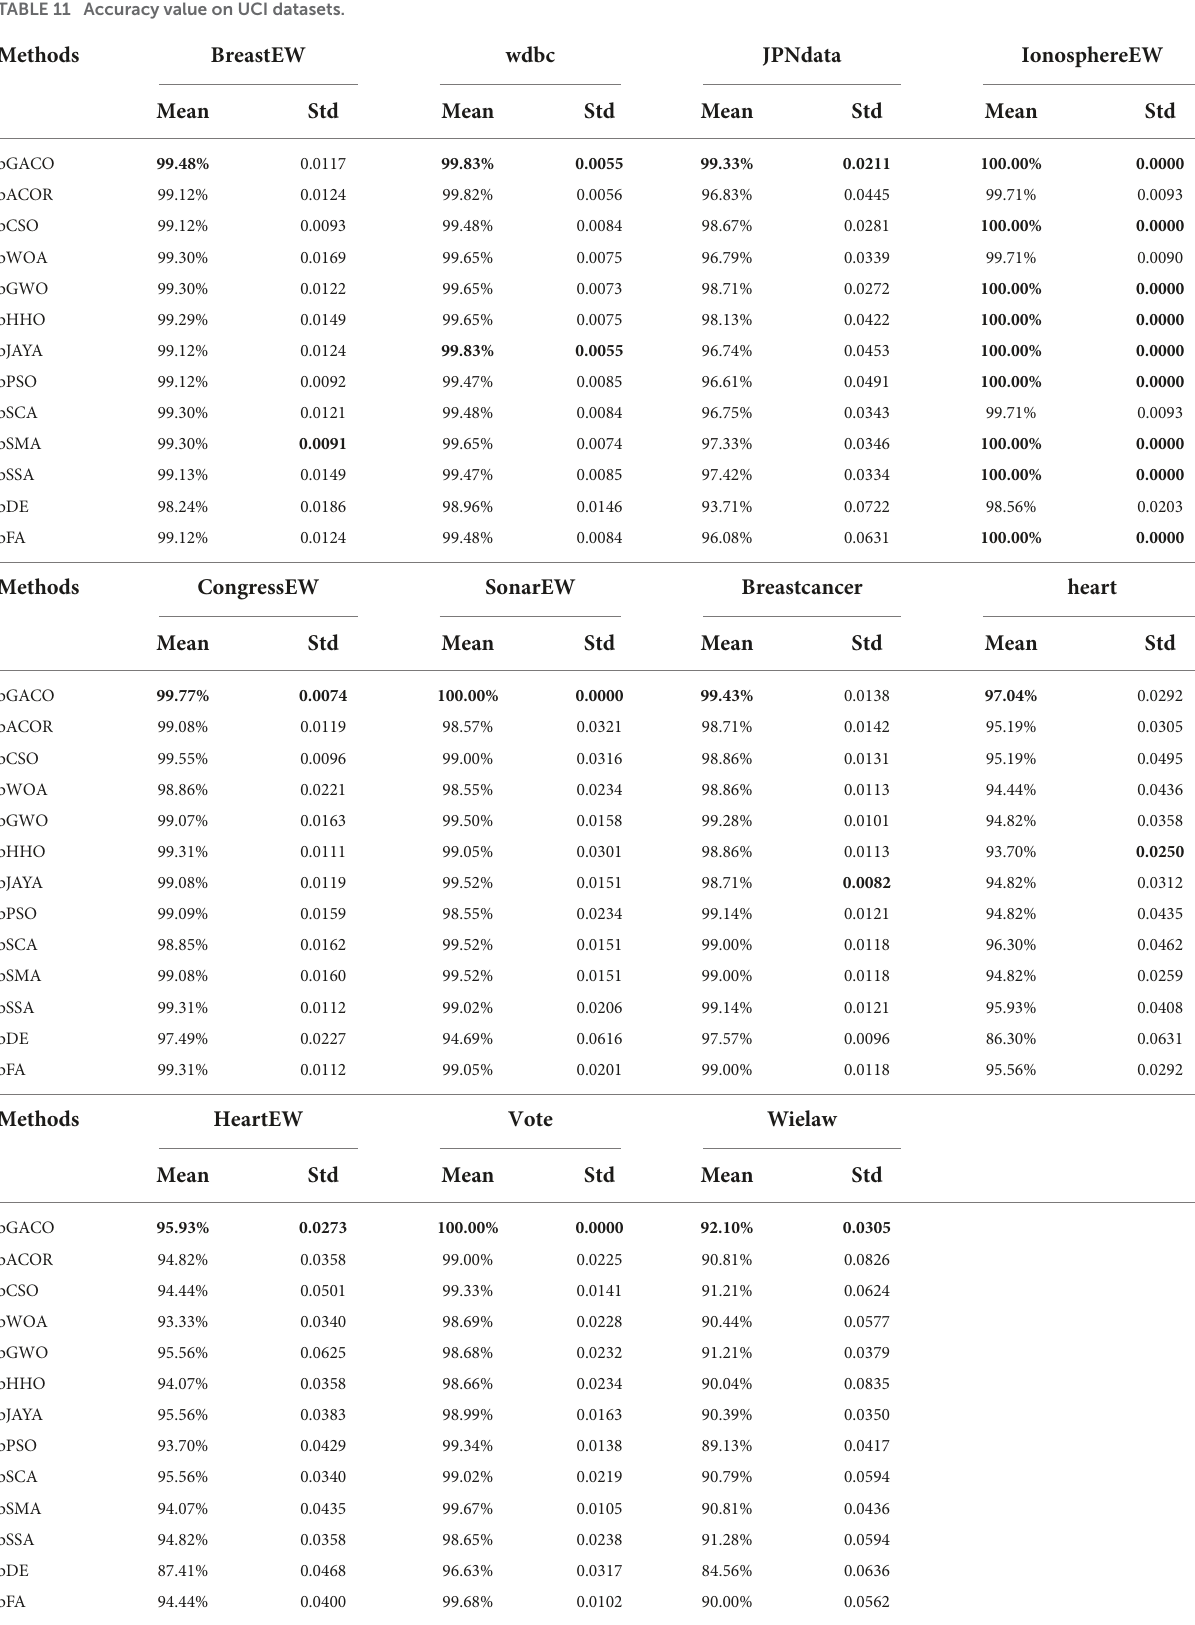
TABLE 11 Accuracy value on UCI